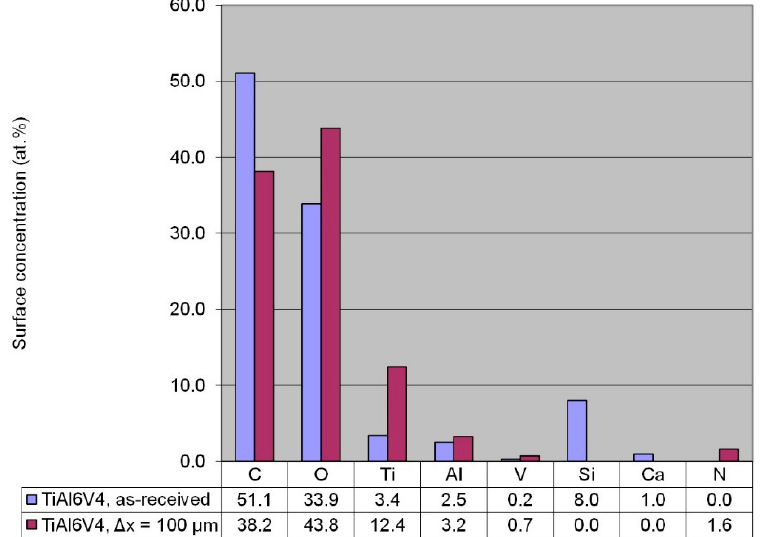
Figure 5. Surface element composition of as-received and laser-textured Ti-6Al-4V ( ∆ x = 100 μ m) samples.